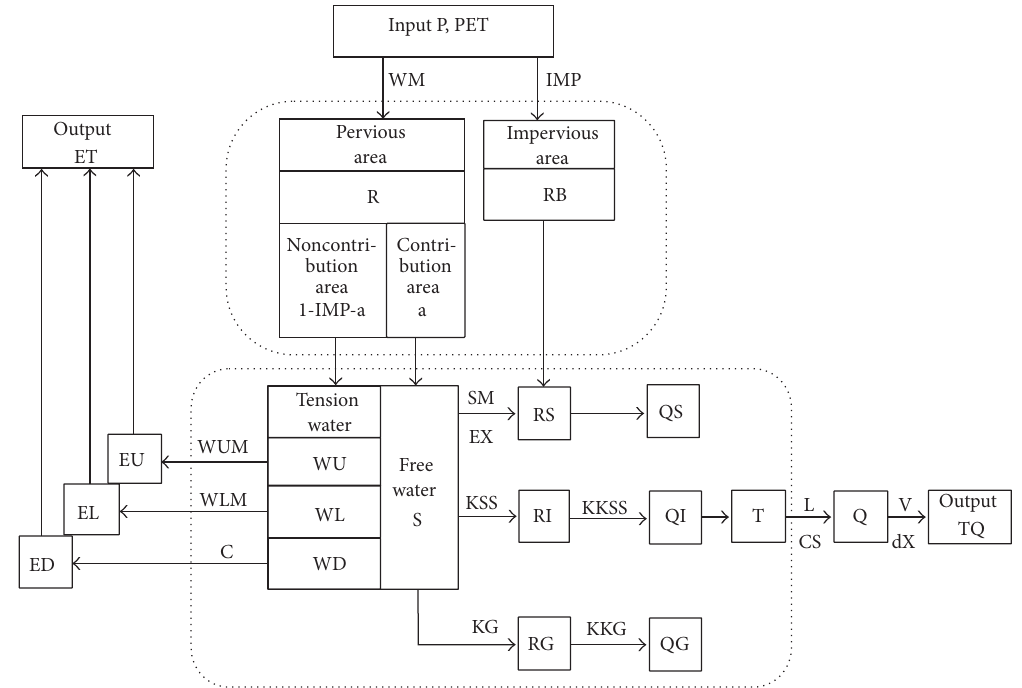
Figure 2: Adopted flowchart of the XAJ model [50], where WU, WL, and WD represent the upper, lower, and deep soil layers’ areal mean tension water storage, respectively; EU, EL, and ED stand for the upper, lower, and deep soil layers’ evapotranspiration output, respectively; S is the areal mean free water storage; a is the portion of the subcatchment which is currently producing runoff; IMP is the factor of impervious area in a catchment; RB is the direct runoff produced from the small portion of impervious area; R is the total runoff generated from the model with surface runoff (RS), interflow (RI), and groundwater runoff (RG) components, respectively. These three runoff components are then transferred into QS, QI, and QG and combined as the total subcatchment inflow (T) to the channel network. The flow outputs from each subcatchment Q are then routed to the catchment outlet to produce the final flow result